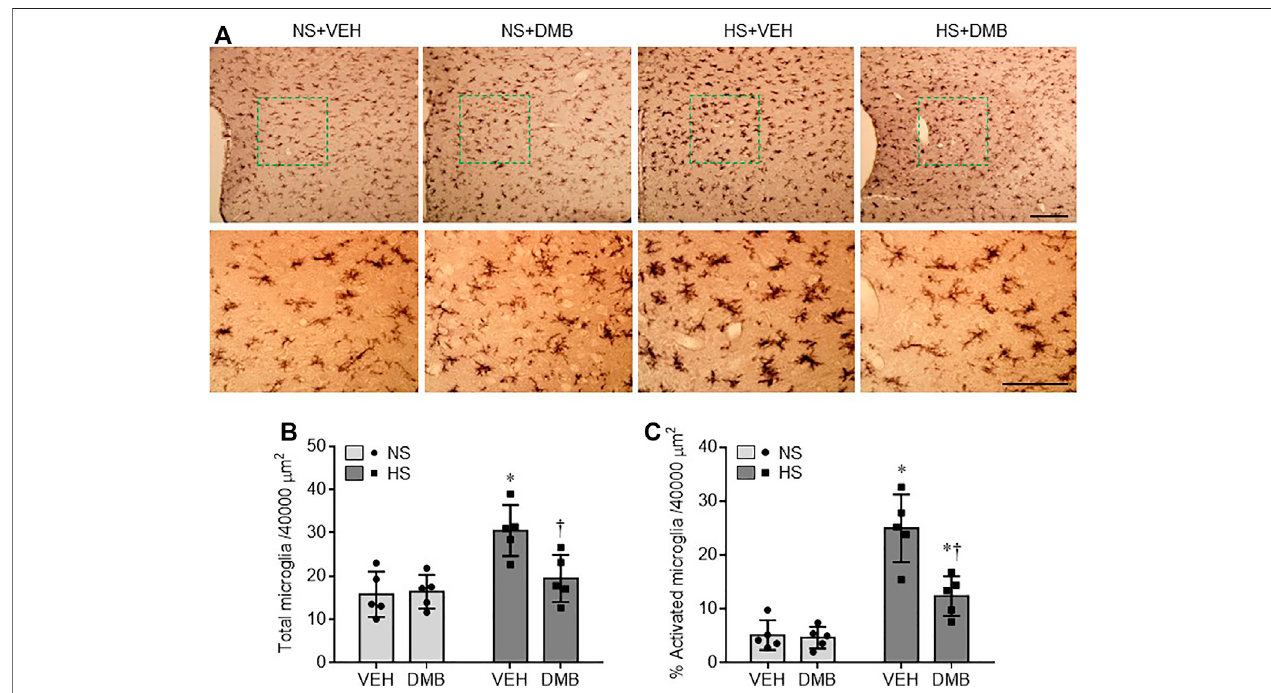
FIGURE3| RepresentativeimagesofimmunohistochemistryshowingCD11b-immunoreactivemicroglia (A) andquantitativecomparisonoftotal (B) andactivated (C) microglia in the PVN inrats fed anormal salt (NS) diet or a high salt (HS) diet and simultaneously treated withvehicle(VEH) or 1.0% 3,3-Dimethyl-1-butanol(DMB, an inhibitor of trimethylamine formation). Scale bar = 100 μ m. All data are expressed as mean ± SEM ( n = 5 rats/per group). p p < 0.05 vs . NS + VEH; † p < 0.05, HS + DMB vs . HS + VEH.